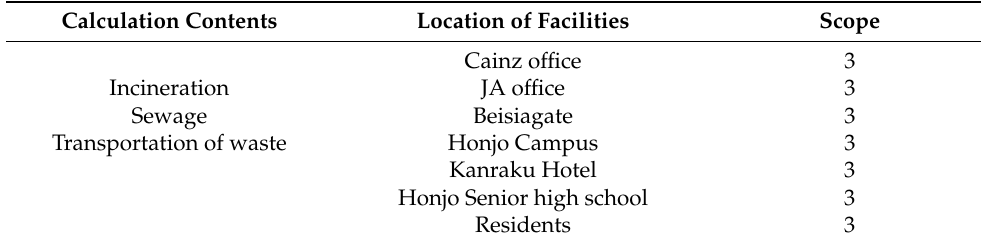
Table 2. Estimation contents of inventory entries.